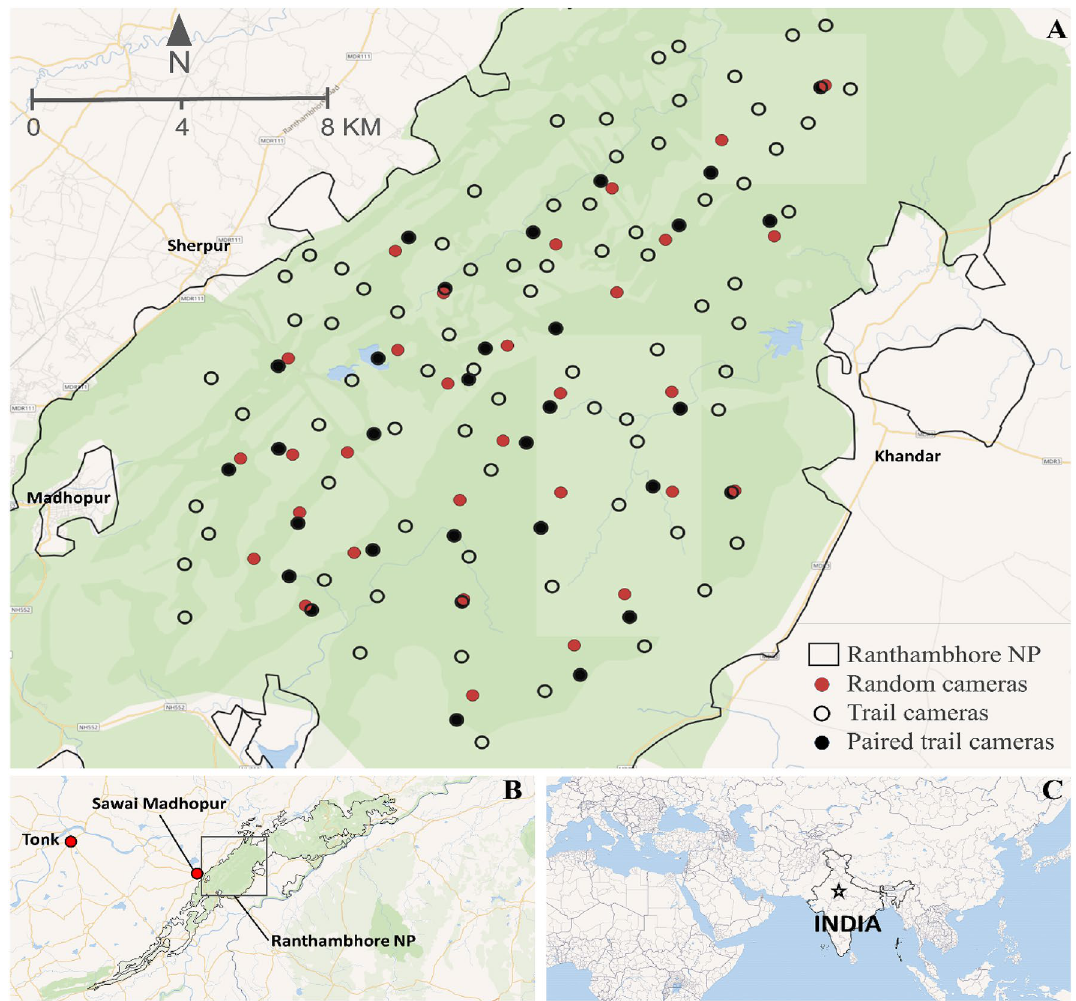
Figure 1. A. Locations of random and trail cameras placement within Ranthambhore National Park. The solid black circles represent trail cameras placed in the proximity of random cameras, i.e., paired trail cameras. Inset: B. Study area extent in Ranthambhore Tiger Reserve (RTR); C. Location of RTR in India. The maps were created using QGIS ( ver. 3.10, https:// downl oad. qgis.